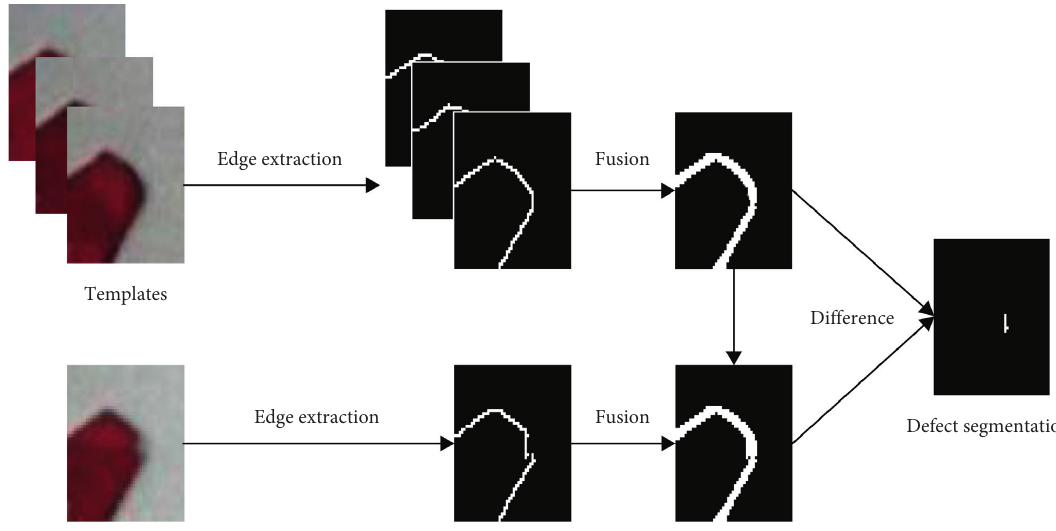
Figure 7: The architecture of the proposed feature fusion and defect segmentation